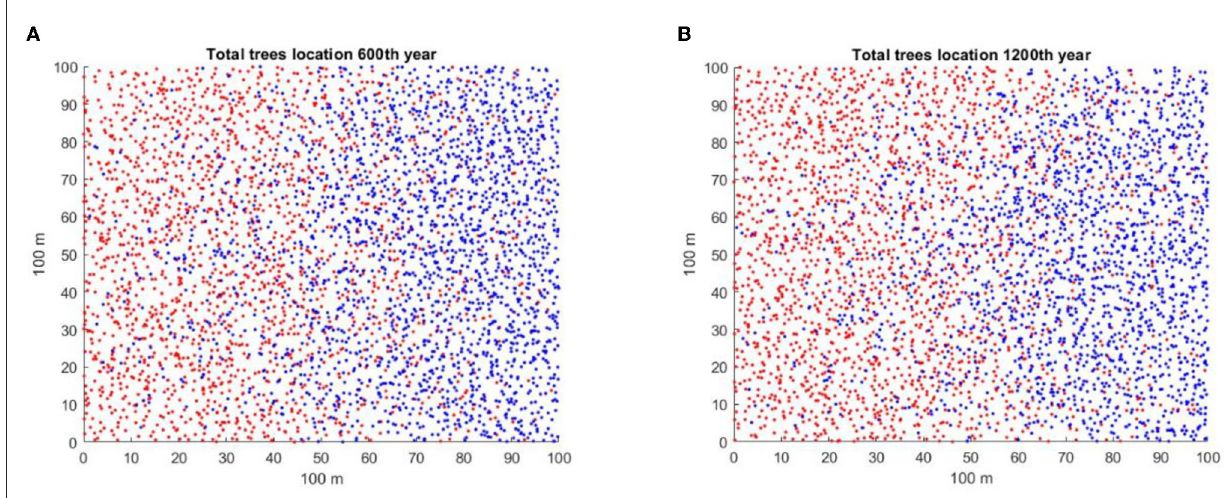
FIGURE7 Spatial distributions of the native (blue) and invader (red) tree populations for the two simulations are shown in Figures A2.3, A2.9. In both cases, s litter = 14 and c 3 = 0.05. (A) Spatial distribution for A2.3 at year 600, initial random number generator = 41, in which the native wins. (B) Spatial distribution for A2.9 at year 1,200, initial random number generator = 43, in which the invader appears to be